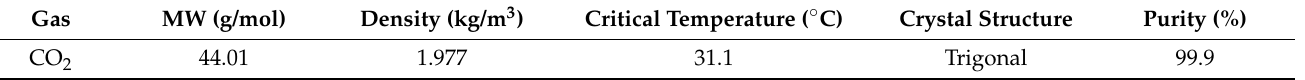
Table 2. Properties of HDPE